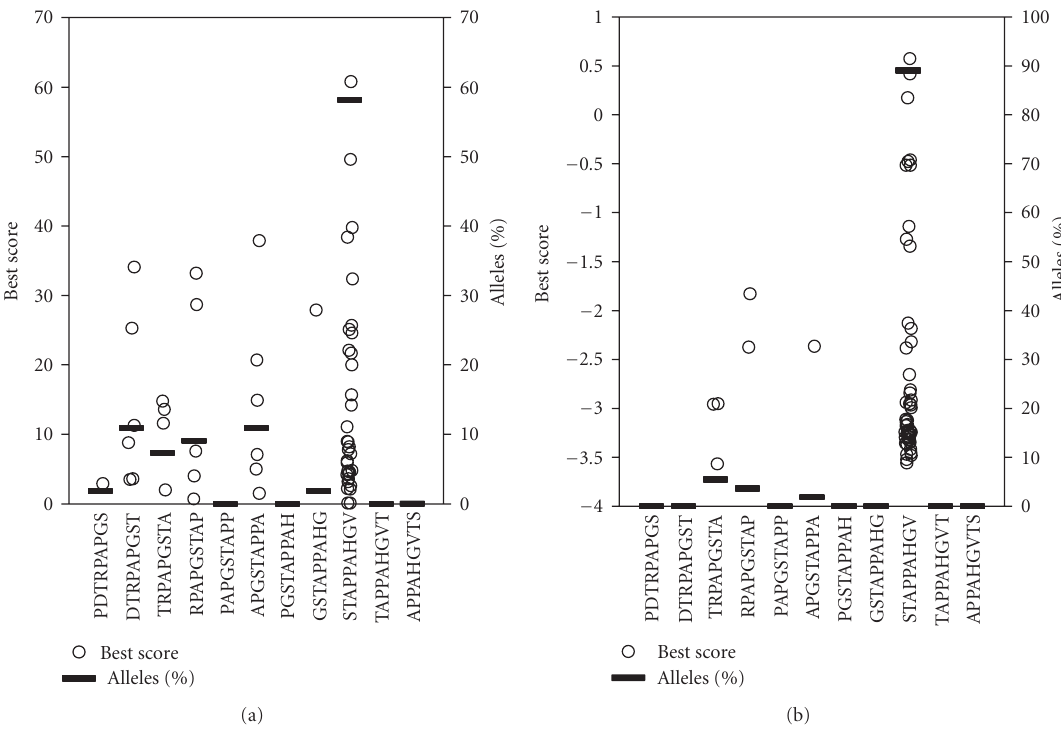
Figure 4: Using the Immune Database and Analysis Resource (IEDB, http://www.immuneepitope.org/) [187] the possible CTL epitopes in the sequence of the tandem repeat PDTRPAPGSTAPPAHGVTS were predicted. (a) Using consensus score only the best sequences for each allele are marked together with their score as well as the percentage of MHC class I alleles (secondary axis) for which the respective sequence is the best scoring sequence in the tandem repeat (the lower score indicates stronger binding); (b) A combined score using the ann algorithm for MHC calss I binding prediction, TAP transport and proteasome cleavage prediction is shown. The presentation is similar to (a). Again only the best-scoring sequences for each allele are shown. The higher scores indicate higher probability of